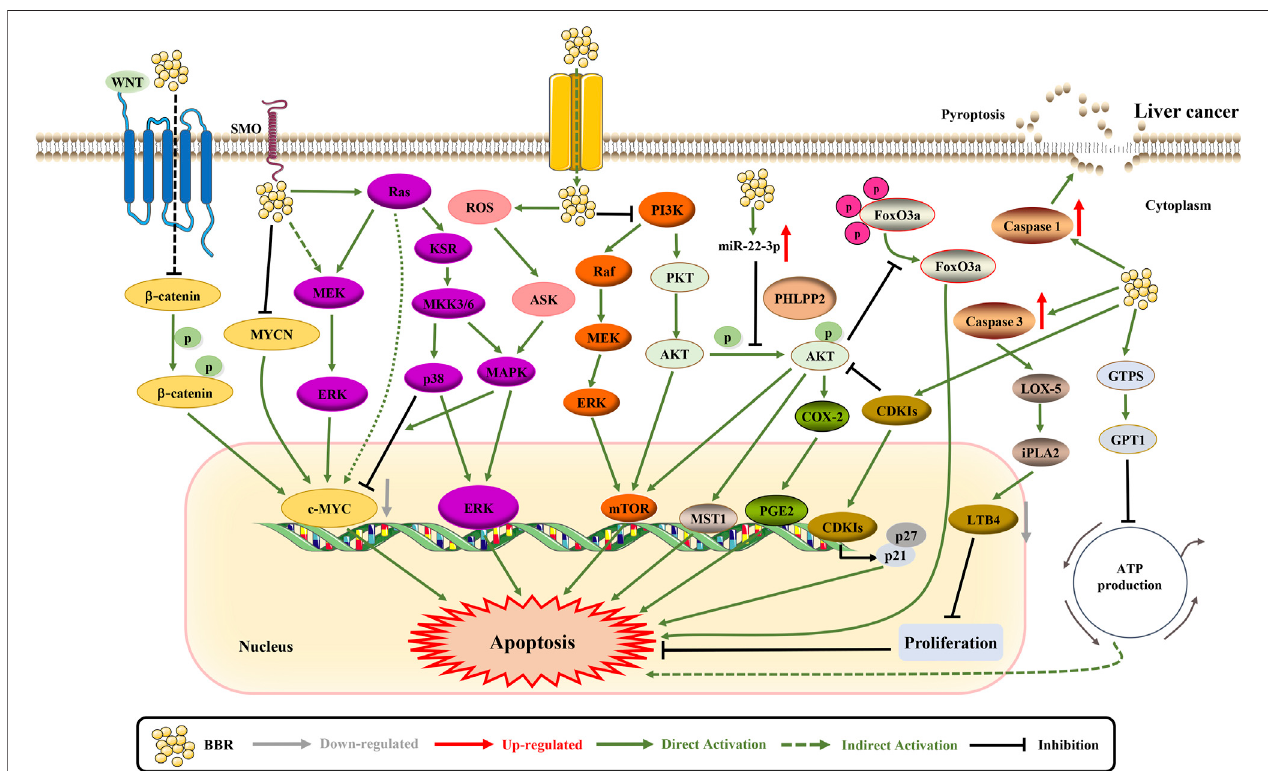
FIGURE 6 | The pro-apoptotic mechanisms of BBR in liver cancer. BBR promotes apoptosis by suppressing the expression of SLC1A5 and c-MYC (Zhang et al., 2019c;Taietal.,2020).BBRincreasestheexpressionofCDKIs p21 Cip1 andp27 Kip1 viaregulatingtheAKT/FoxO3a signalingpathway (Guoetal.,2020).Likewise,BBR induces apoptosis through iPLA2/LOX-5/LTB4 pathway and PHLPP2-AKT-MST1 axis (Saxena et al., 2018; Zhao et al., 2020). Besides, BBR inhibits cell proliferation through ERK1/2 and GPT1 axis (Chuang et al., 2017; Guo et al., 2020). BBR can regulate adenylate cyclase signaling in association with MKK3/6 stabilization to exert necroptosis (Sengupta et al., 2017). BBR upregulates miR-22-3p to inhibit cell proliferation (Chen et al., 2016). Furthermore, BBR simultaneously inhibits NF- κ B p65and β -catenintranslationtopromoteapoptosis(Lietal.,2017).TheapoptosispromotionofBBRmayalsoberelatedtotheinhibitionofPI3K/AKT,p38MAPK/ERK- COX2 and HIF-1 α (Luo et al., 2019b; Song et al., 2019b; Qi and Liu,